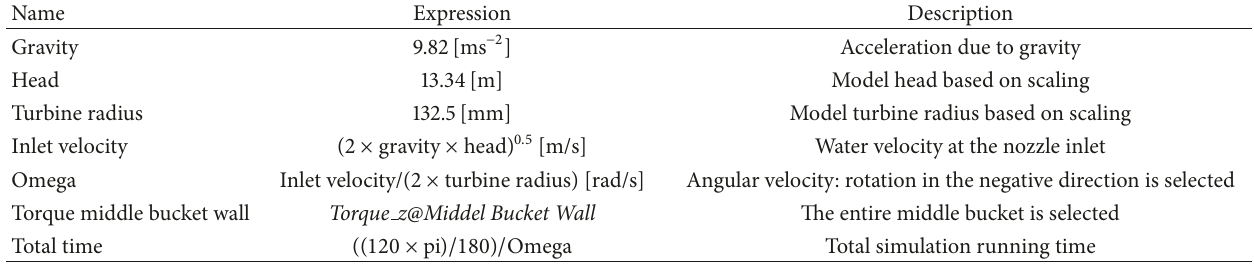
Table 8: Expressions defined in ANSYS Pre for the baseline design [5, 11].